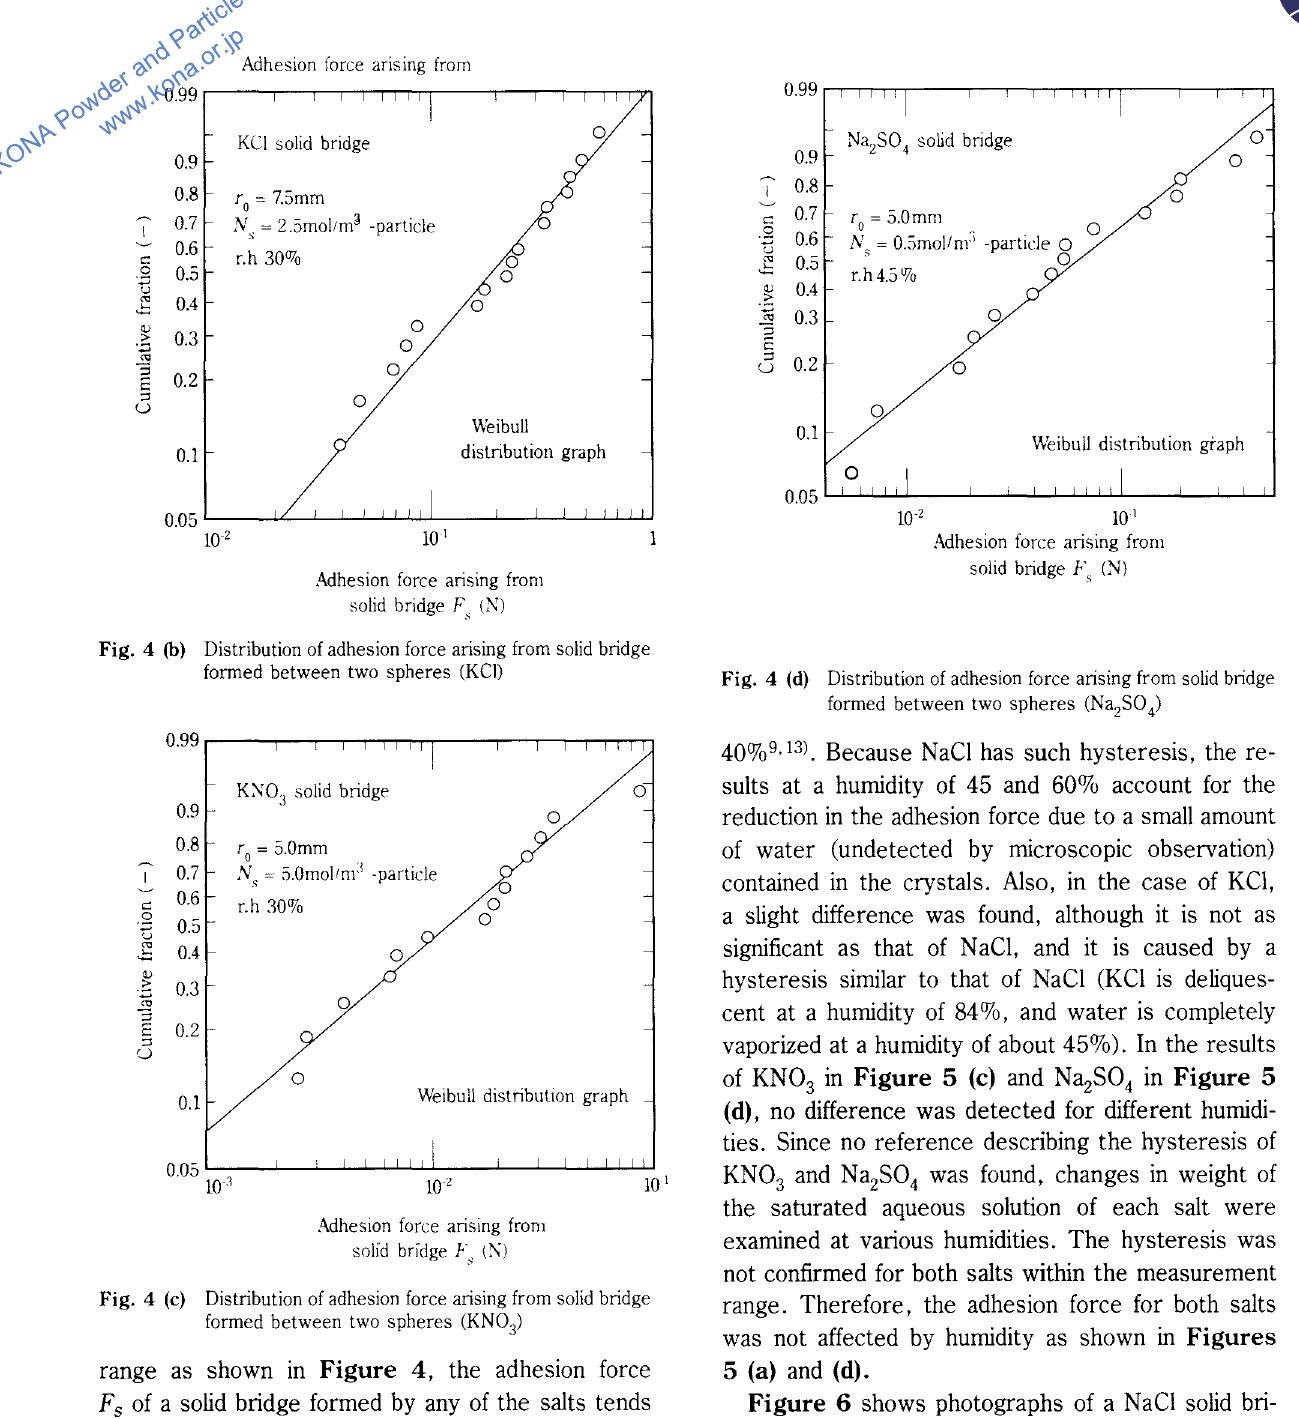
Fig. 4 (b) Distribution of adhesion force arising from solid bridge formed between two spheres (KCI) Fig. 4 (c) Distribution of adhesion force arising from solid bridge formed between two spheres (KN0 3) range as shown in Figure 4, the adhesion force